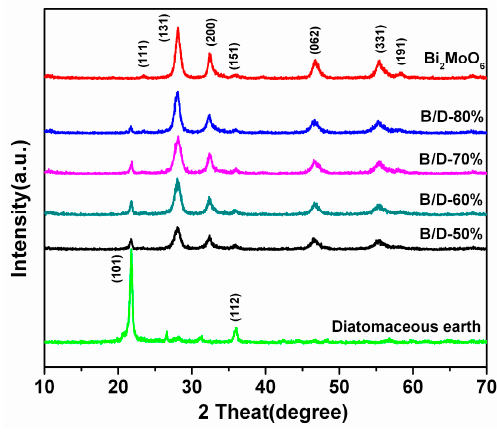
Figure 1. XRD patterns of Bi 2 MoO 6 , B/D-50%, B/D-60%, B/D-70%, B/D-80%, and diatomite.